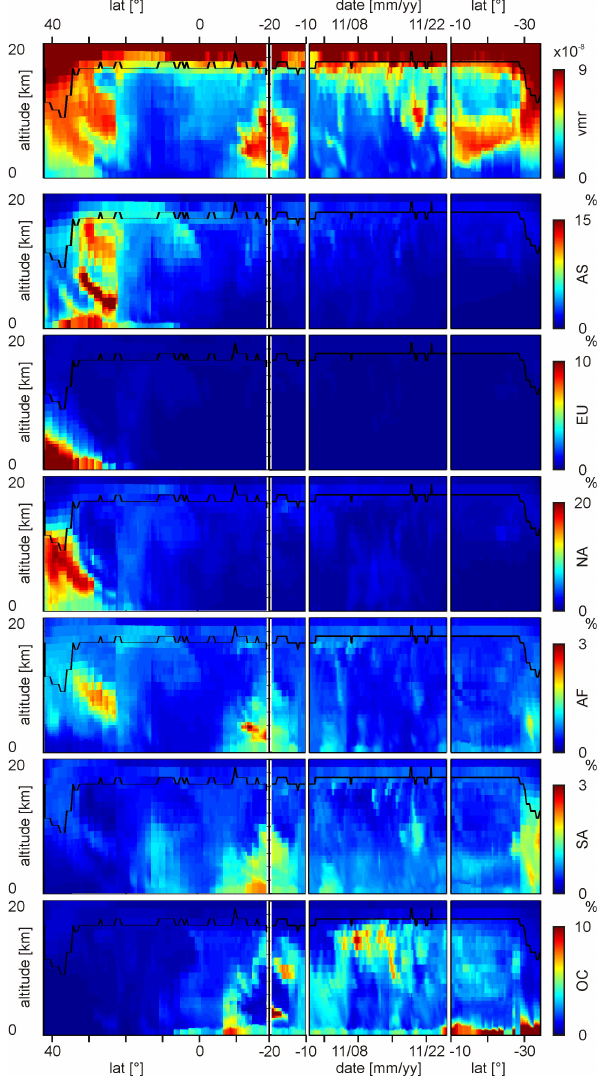
Fig. 9. Relative contributions of various GEOS-Chem tagged re- gions to the measured O 3 pollution calculated with the tagged-O 3 simulation. AS: Asia, EU: Europe, NA: North America, AF: Africa, SA: South America, OC: Oceania. The black line in each graph in- dicates the model tropopause